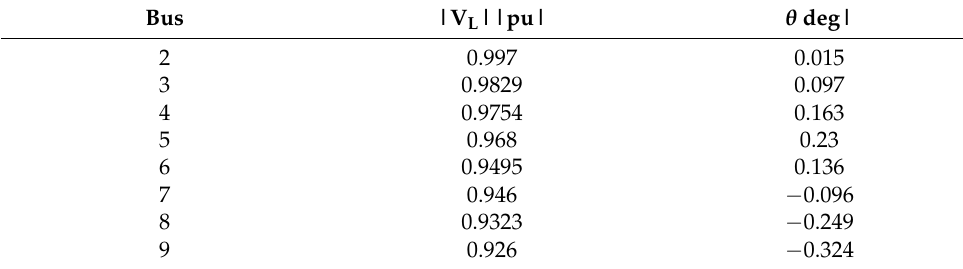
Table A2. IEEE 33 Bus Voltage